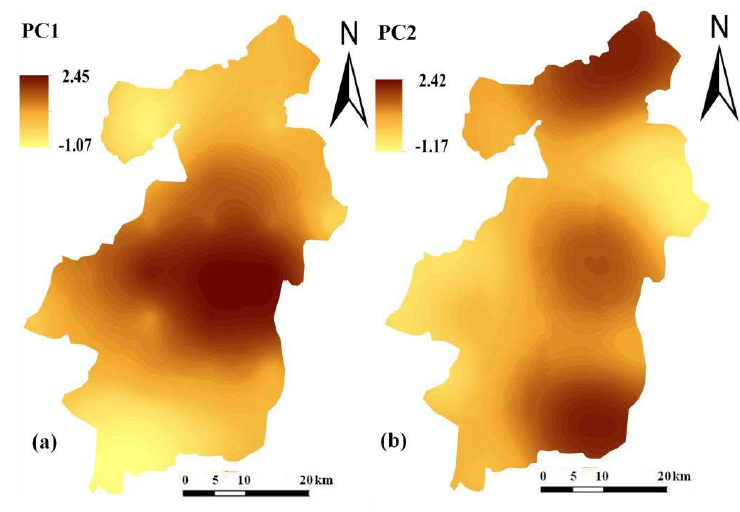
Figure 4. Spatial distribution patterns of PC1 ( a ) and PC2 ( b ) in the topsoil.